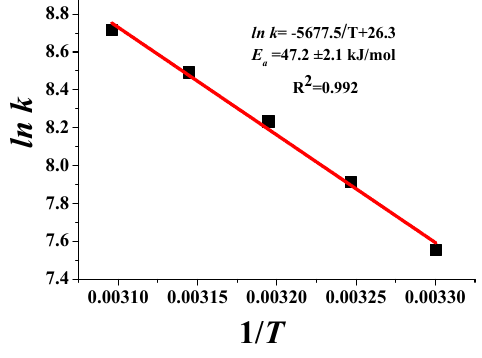
Figure 7. Linear fit of ln k to 1/ T of Rh 10 Ni 90 catalyst for hydrogen generation from KBH 4 ( R ISO = 40, C Metal = 0.66 mM, reduced under ice ‐ water bath for 1 h; pH = 12 for H 2 generation, 30 °C).